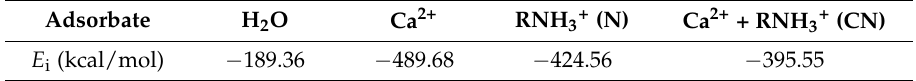
Table 3. The interaction and binding energies between adsorbates and the sillimanite (010) surface.